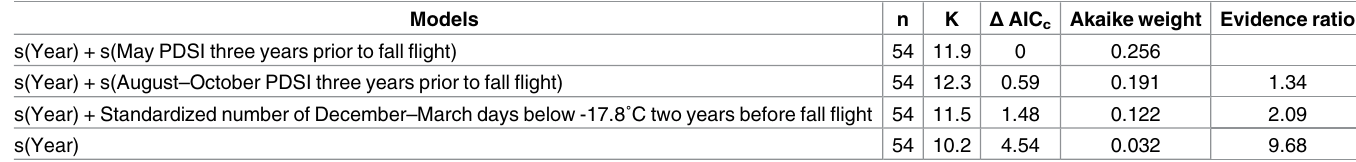
Table 4. Time trend and weather models for beaver colony density on streamswhere no targeted beaver management occurred on the Nicolet side of the Chequamegon-Nicolet National Forest, 1987–2013. Models listed are the minimum AIC model, competitivemodels (those models within 2 AC units of the minimum), and the trend model.